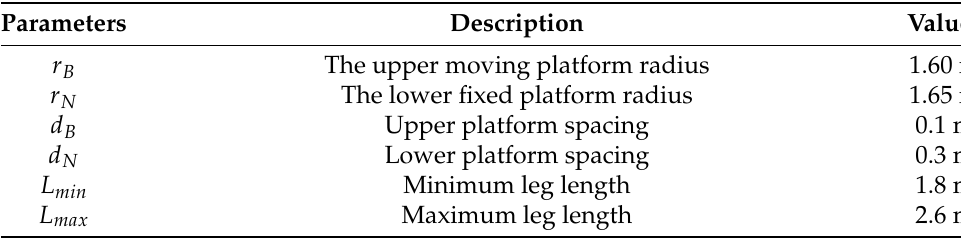
Table 2. The geometric parameters of the G-S platform.